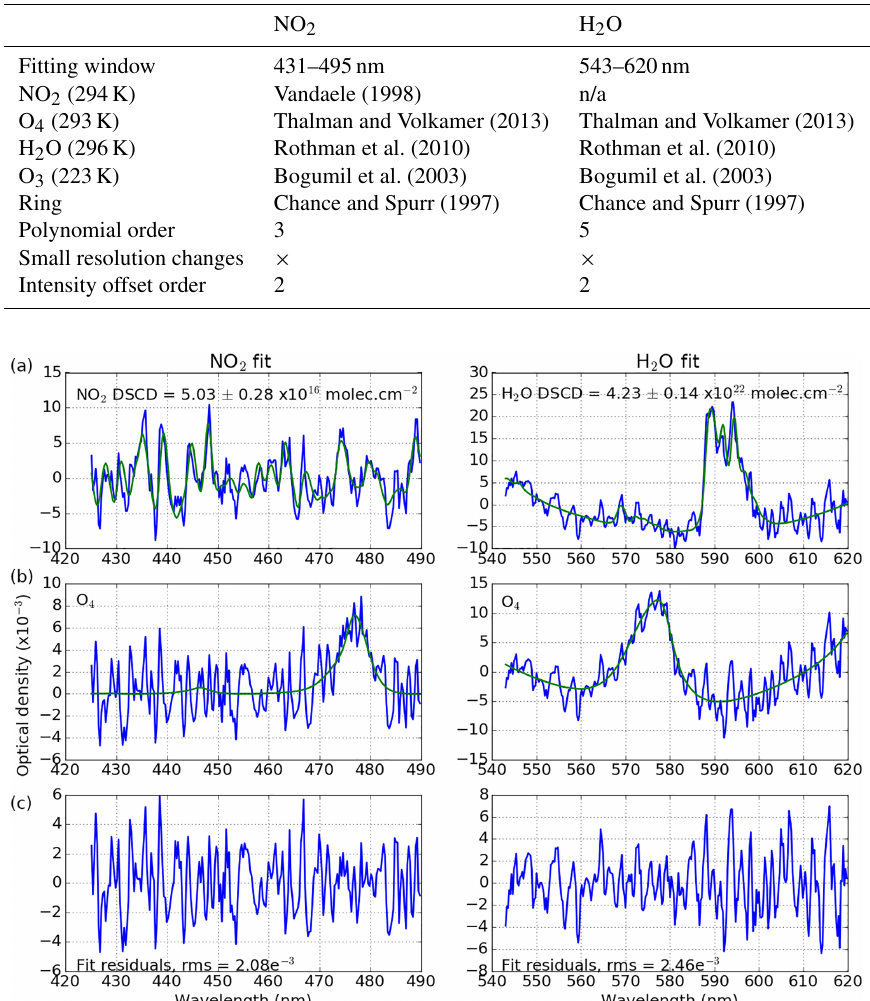
Figure 7. Example of DOAS fits of NO 2 and H 2 O in SWING spectra (a) . The figure also shows O 4 fits (b) and the fit residuals (c)